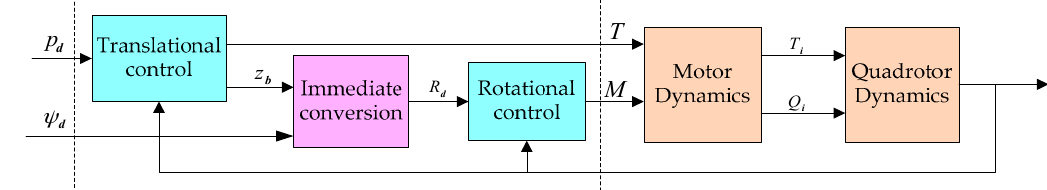
Figure 2. Control structure diagram.